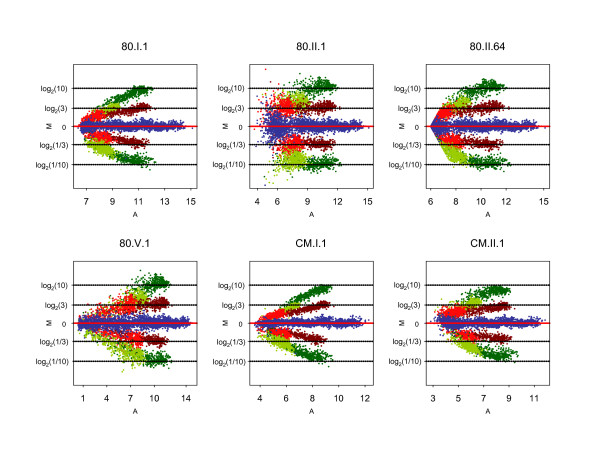
MA-plots for the selected normalizations. MA-plots for six normalizations. The coloring corresponds to genes 1–18 in Figure 2: NDE-genes (1–10) are blue, highly-regulated genes (i.e. ratio 1/10 or 10) expressed at high concentrations (12, 18) are dark green, highly-regulated genes expressed at low concentrations (11, 17) are light green, moderately-regulated genes (i.e. ratio 1/3 or 3) expressed at high concentrations (14, 16) are brown, and moderately-regulated genes expressed at low concentrations (13, 15) are colored red.